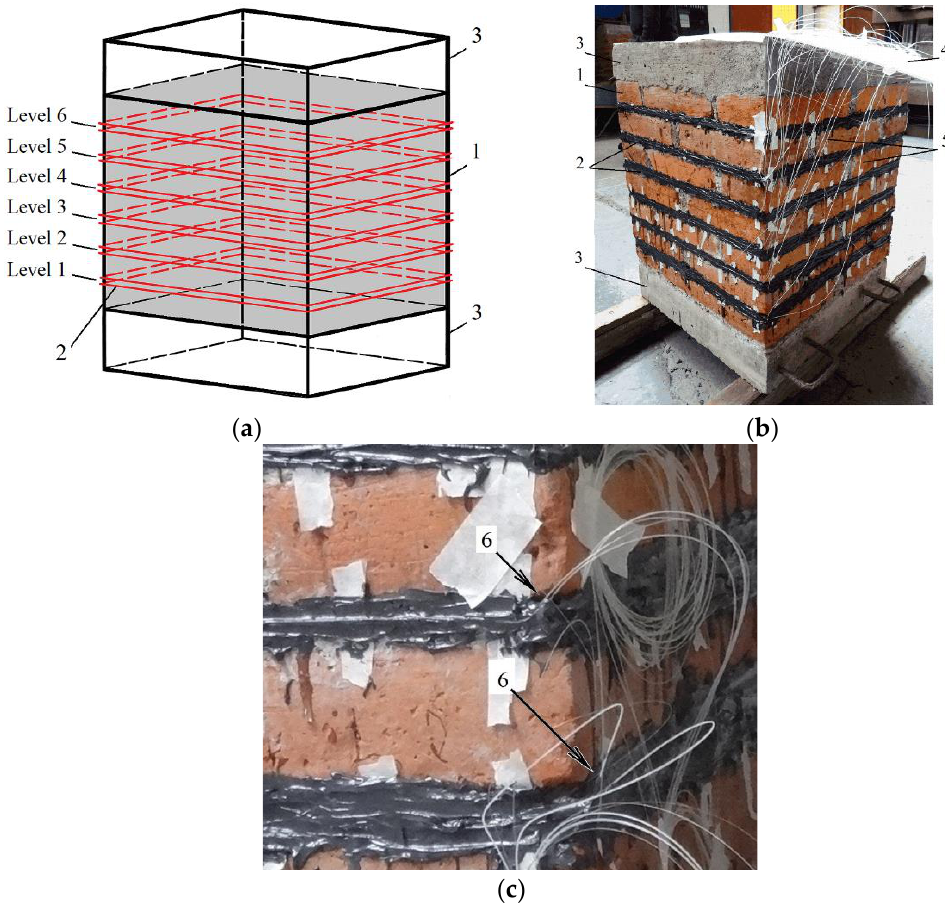
Figure 3. Brick masonry specimen instrumented with the optical fibers: ( a ) schematic; ( b ) photograph; ( c ) an enlarged view of the points of connection of optical fibers to the specimen (photos). (1) Brick masonry specimen; (2) segments of optical fibers bonded to masonry that serve as crack detectors (not visible under opaque epoxy adhesive); (3) RC platen; (4) tray with free ends of the optical fibers; (5) free ends of the optical fibers; (6) points of connection of the optical fibers to the masonry specimen.